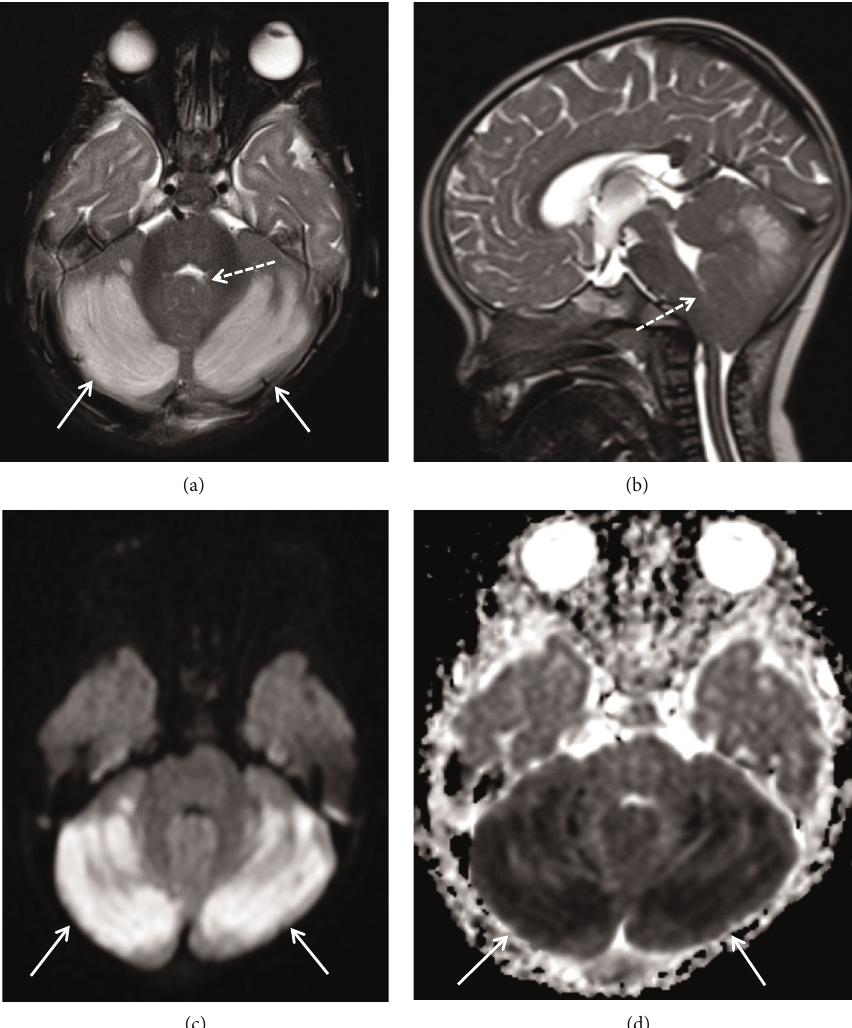
Figure 3: MRI at the time of presentation. (a) Axial T2-weighted image shows bilateral cerebellar edema (arrows) with e ff acement of the inferior fourth ventricle (dashed arrow). (b) Midsagittal T2 weighted image shows posterior fossa crowding with e ff acement of the inferior fourth ventricle (dashed arrow). (c) Di ff usion imaging and (d) apparent di ff usion coe ffi cient (ADC) map show true restricted di ff usion in the cerebellar hemispheres (arrows) in the region of T2 signal abnormality consistent with cytotoxic cerebellar